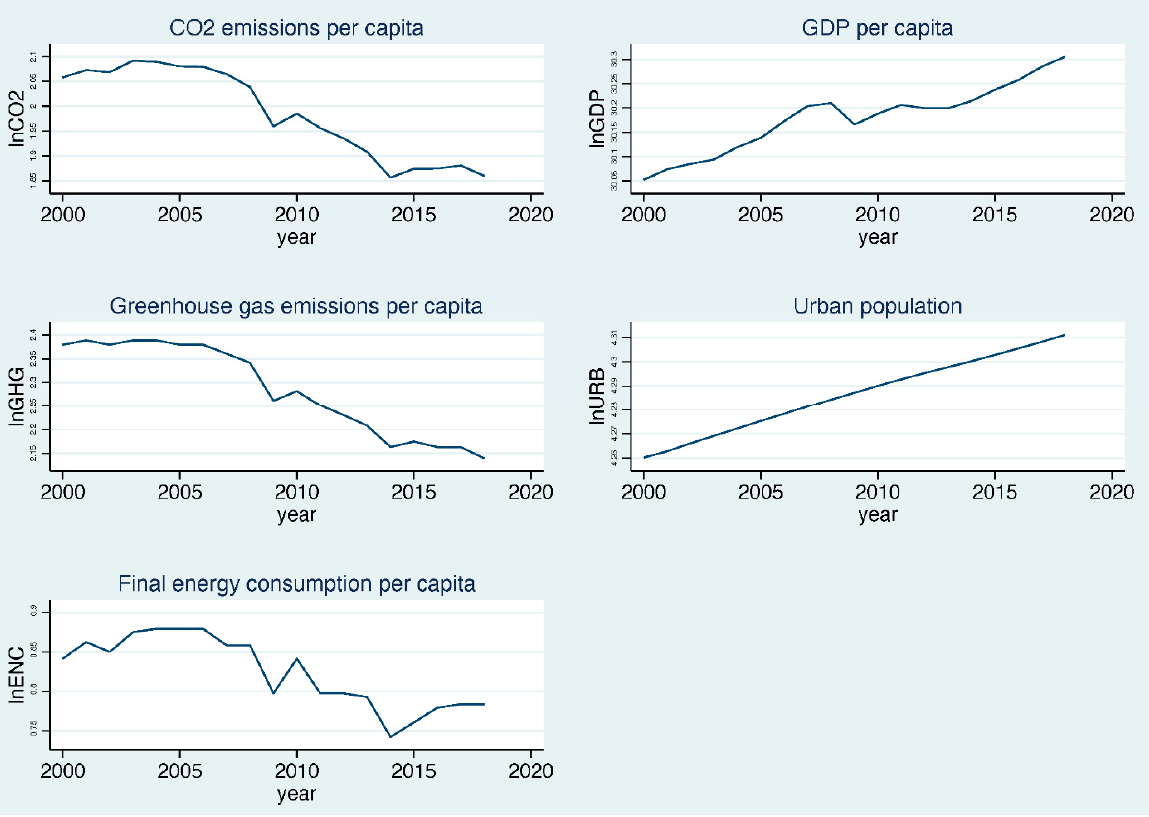
population, and final energy consumption per capita in the European Union between 2000 and 2018.